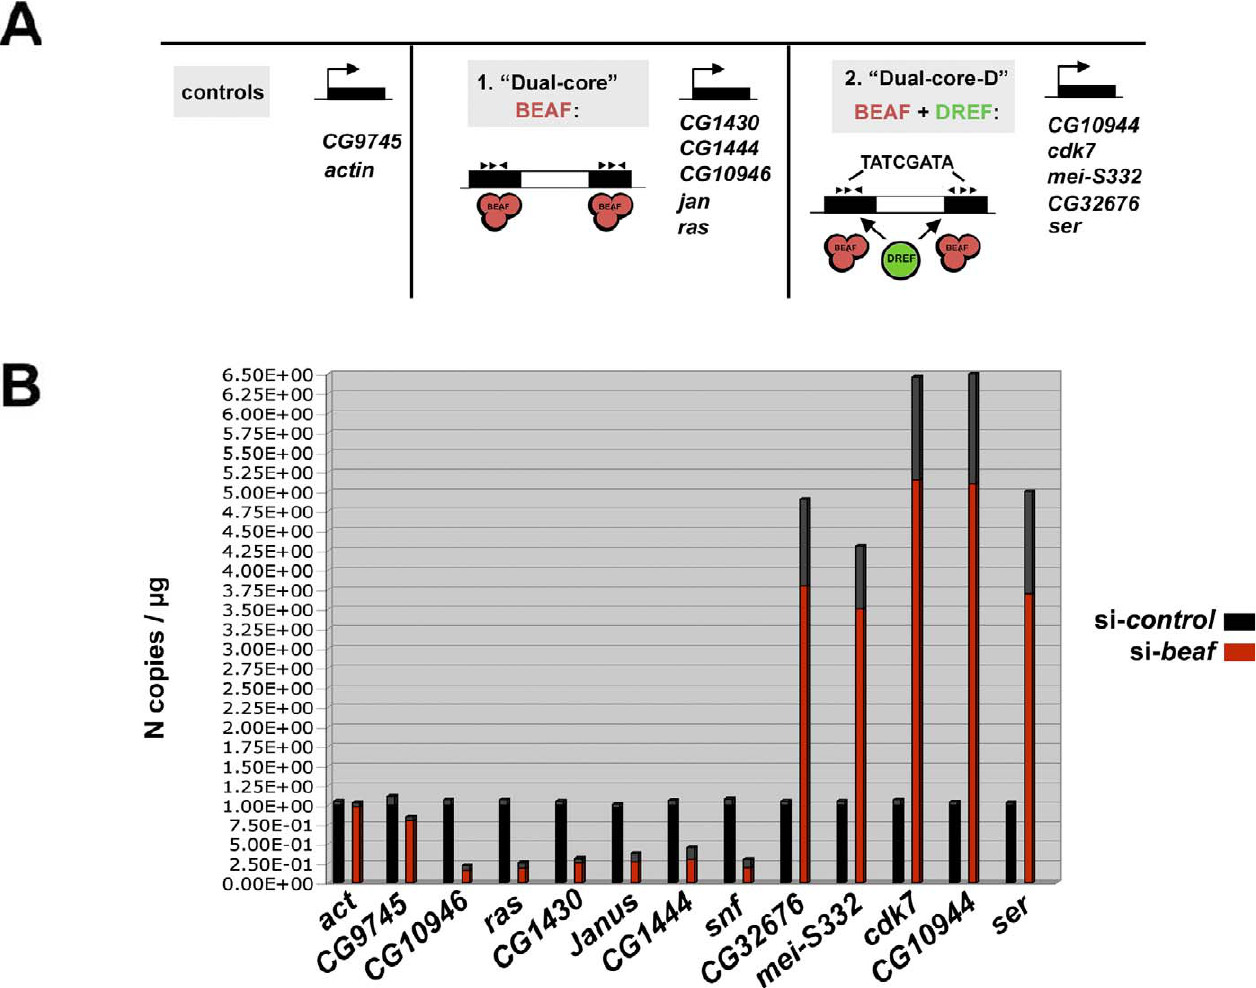
Figure 4. DREF Modulates the Activity of BEAF Dual-Cores Associated with Key Cell-Cycle Genes (A) Schematic representation of the two distinct classes of BEAF dual-cores depending on the presence of an additional consensus (TATCGATA) for the transcription factor DREF (denoted ‘‘ Dual-core_D ’’ ; see our database and text). (B) Quantitative RT-PCR analysis of the expression of a control gene (left; actin , CG9745 ), of dual core-associated genes (without a TATCGATA DREF element, middle; CG1430 , CG1444 , CG10946 , janus ( jan ), rasberry ( ras )) or of dual core_D–associated genes (with a DREF element, right; CG10944 , cdk7 , mei-S332 , CG32676 , serendipity ( ser )) in BEAF-depleted (red bars) or control cells (black bars). The y -axis shows the number of copies of amplification products per l g of RNA normalized for each gene in control cells (see Materials and Methods), where N ¼ 1 corresponds to 8,450 copies of actin , 14,930 copies of CG9745 , 29,300 copies of CG10946 , 24,800 copies of ras , 23,020 copies of CG1430 , 43,020 copies of janus , 29,370 copies of CG1444 , 80,390 copies of snf , 48,393 copies of CG32676 , 56,300 copies of mei-S332 , 114,500 copies of cdk7 , 32,830 copies of CG10944 , and 49,620 copies of serendipity . The copy number was estimated using a standard curve obtained from more than three different quantities of genomic DNA. Experimental error from three independent experiments is denoted by the differentially colored (gray) portion at the top of each